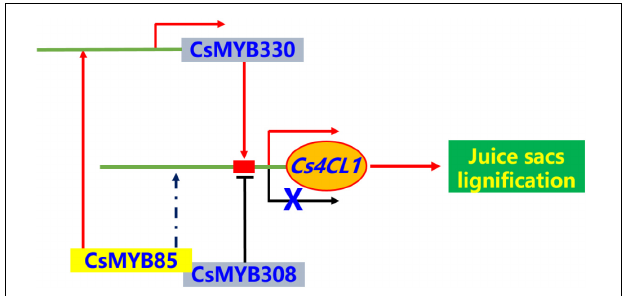
FIGURE 9 | The brief model for regulatory network of Citrus sinensis fruit juice sacs lignification. The MYB transcription factors can activate or inhibit the expression of lignin biosynthesis related genes in Citrus sinensis fruit juice sacs. The Cs4CL1 gene directly involved in lignin biosynthesis. The transcription factors, CsMYB330 and CsMYB330, regulated expression of Cs4CL1 gene, directly. The CsMYB85 transcription factor can interactive with CsMYB308 and regulated expression of CsMYB330 gene, and indirectly regulated expression of Cs4CL1